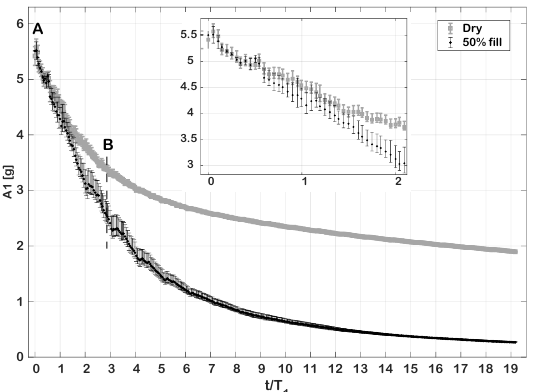
Figure 11. Typical sloshing response of the MiniWoT structure, 50% filling level case compared to dynamically equivalent dry case.